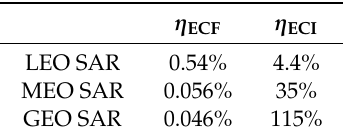
Figure 7. Baseline calculated using ECF equation, ECI equation, and STK data. ( a ) LEO SAR formation; ( b ) MEO SAR formation; ( c ) GEO SAR formation. Table 3. Normalized baseline error using ECEF-RME or ECI-RME in LEO SAR, MEO SAR, and GEO